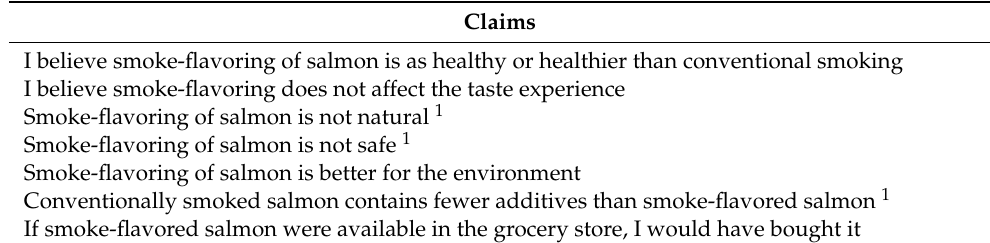
Table 2. Claims for measuring immediate attitudes towards smoke-flavoring of CSS.